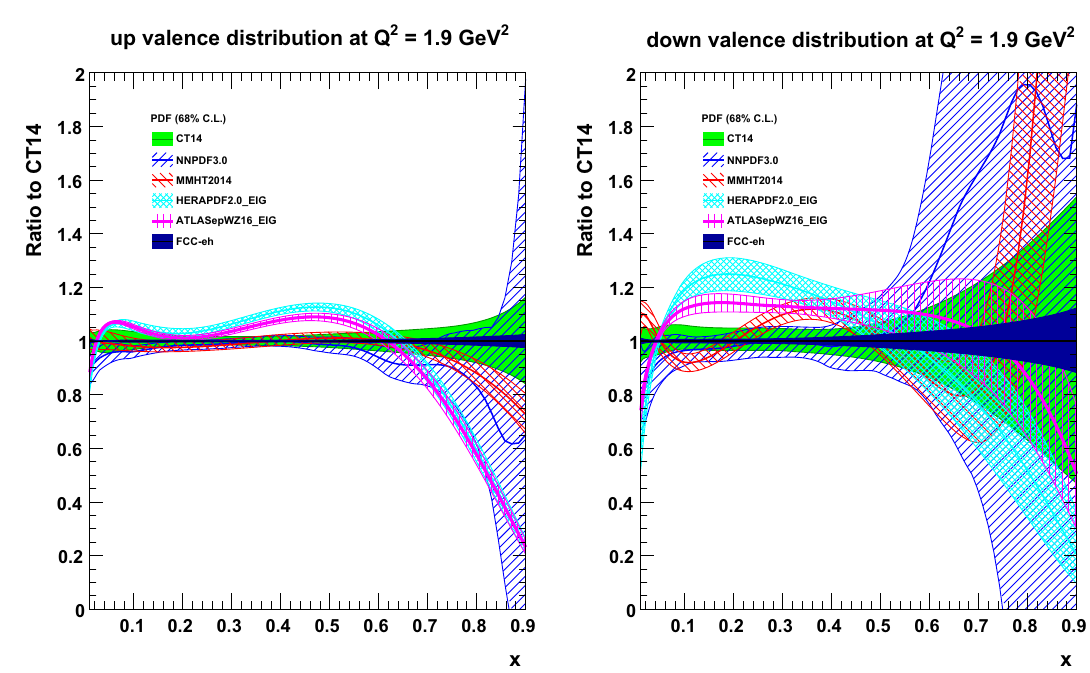
Fig. 5.10 Valence quark distributions at Q 2 = 1 . 9 GeV 2 as a function of Bjorken x , presented as the ratio to the CT14 central values. The FCC-eh PDF values are adjusted to the central value of CT14 and the uncertainties correspond to the dark blue bands